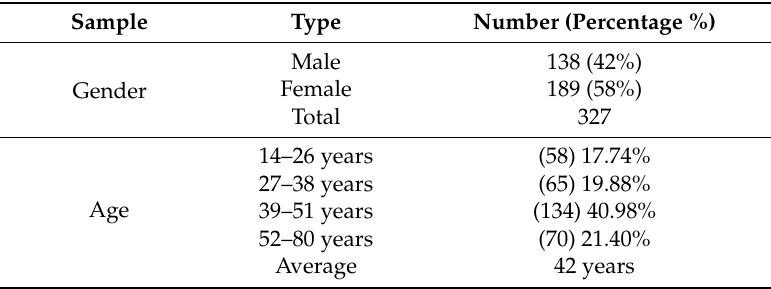
Table 4. Participant demographic